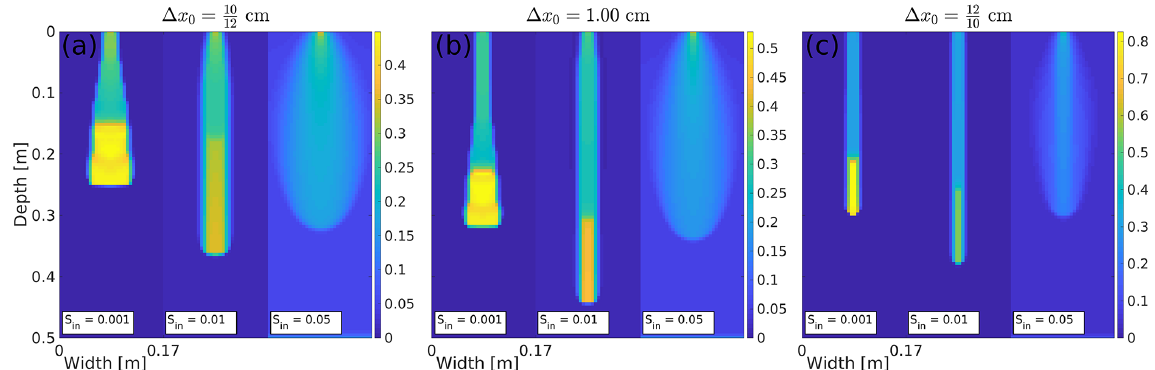
Figure 2. Snapshots of the saturation field for various (cid:49)x 0 for an initially dry ( S in = 0 . 001), a medium dry ( S in = 0 . 01) and a wet ( S in = 0 . 05) porous material. The moisture profiles for (a) (cid:49)x 0 = 10 20min, respectively. Saturation values are color coded according to the color bar on the right.